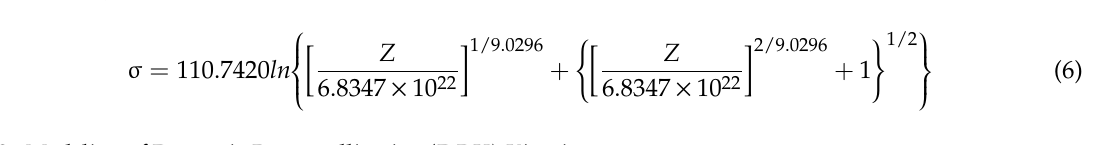
Figure 4. The relationships between ( a ) l𝑛ε(cid:4662) − 𝑙𝑛𝜎 , ( b ) l𝑛ε(cid:4662) − 𝜎